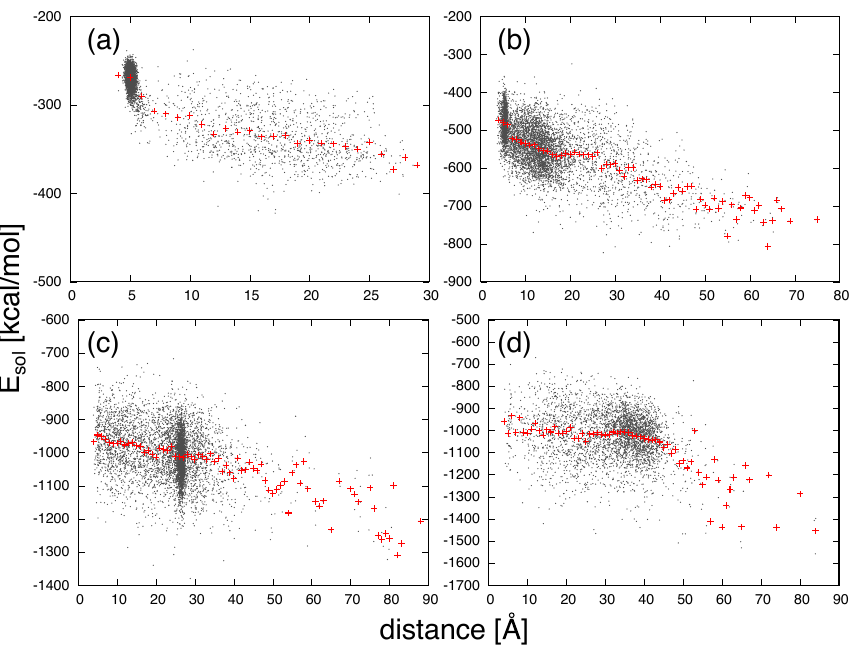
Figure 7. Solvation free energy ( E sol ) of ( a ) CLN025, ( b ) mGTT, ( c ) mNuG2, and ( d ) m α 3D as a function of the end-to-end distance. A red point represents the average value for each width of 1 Å. Finally, we show the temperature dependence of the average value of the SFE with different end-to-end distances in Figure 8. The triangles, crosses, and squares correspond to the average values of the SFE for end-to-end distances of 10, 20, 30, and 40 Å, respectively. Note that the conformational energy of a protein does not depend on temperature because the structures are extracted in the same simulations. The actual distribution of protein structures will be different when MD simulations are conducted at different temperatures. We ignored this point herein.